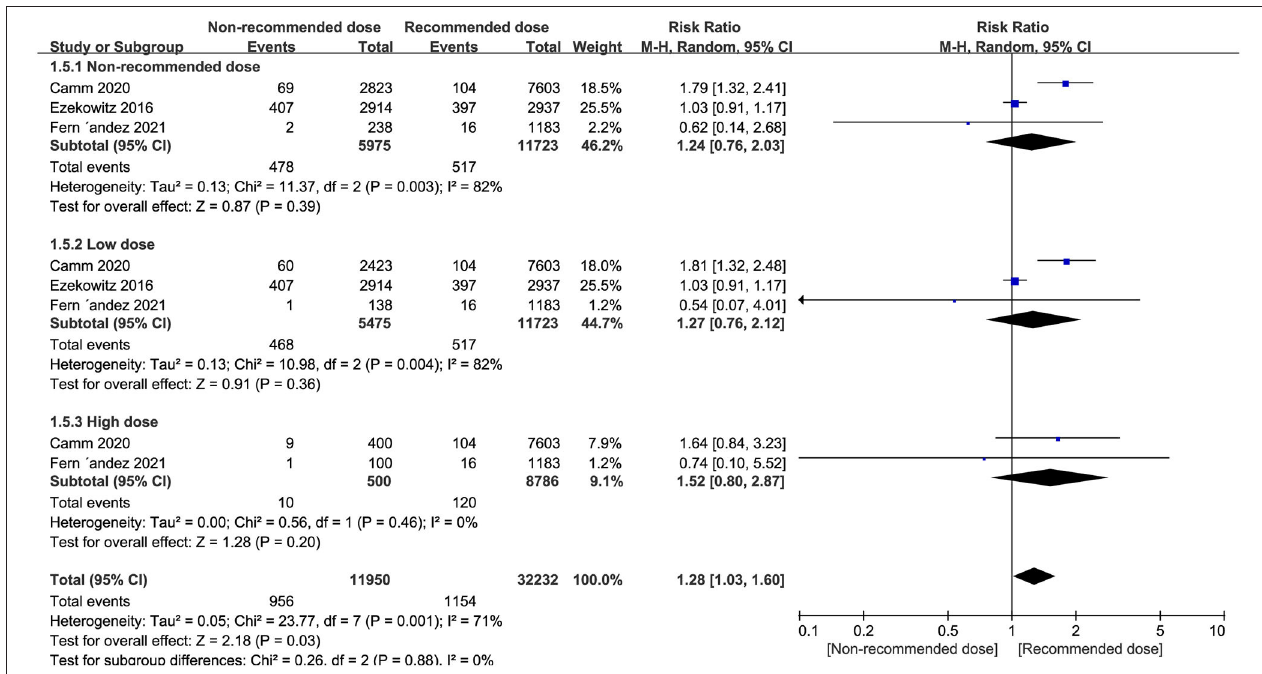
FIGURE 5 | Forest plot for cardiovascular cause of death in non-recommended dose compared to recommended dose of NOACs. NOACs, new oral